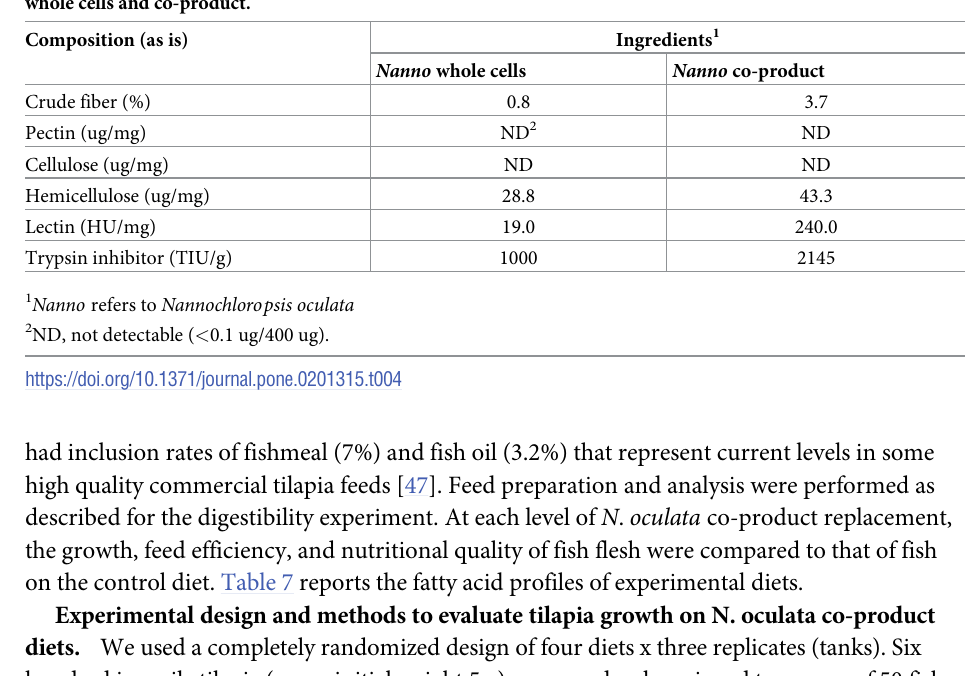
Table 5. Macro minerals and trace elements in the Nannochloropsisoculata ( Nanno ) whole cells and co-product.